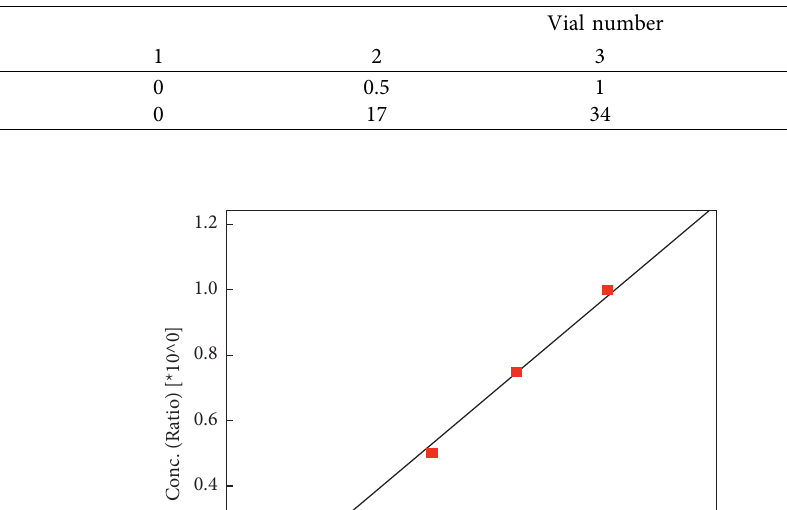
Table 2: Amount of technical hexane added in 20g of oil.